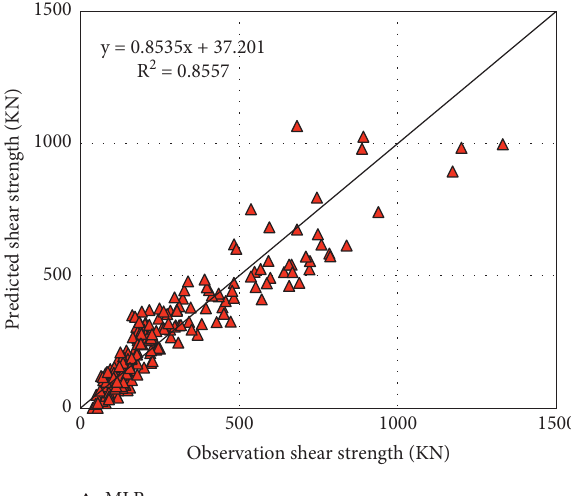
Figure 11: Target (experimental) versus predicted values of shear strength for multiple linear regression model using all data.